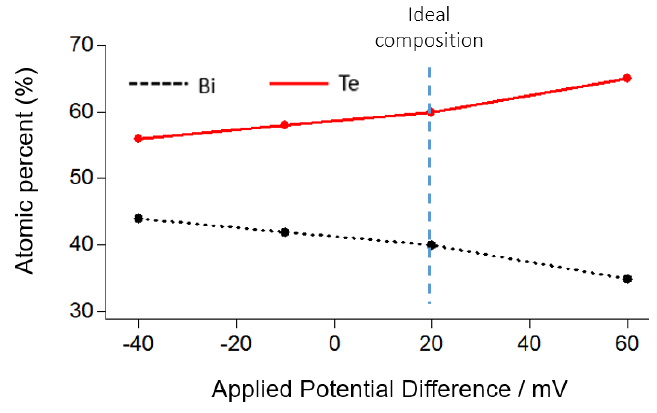
Figure 3. Potential dependence on the atomic composition of BiTe.